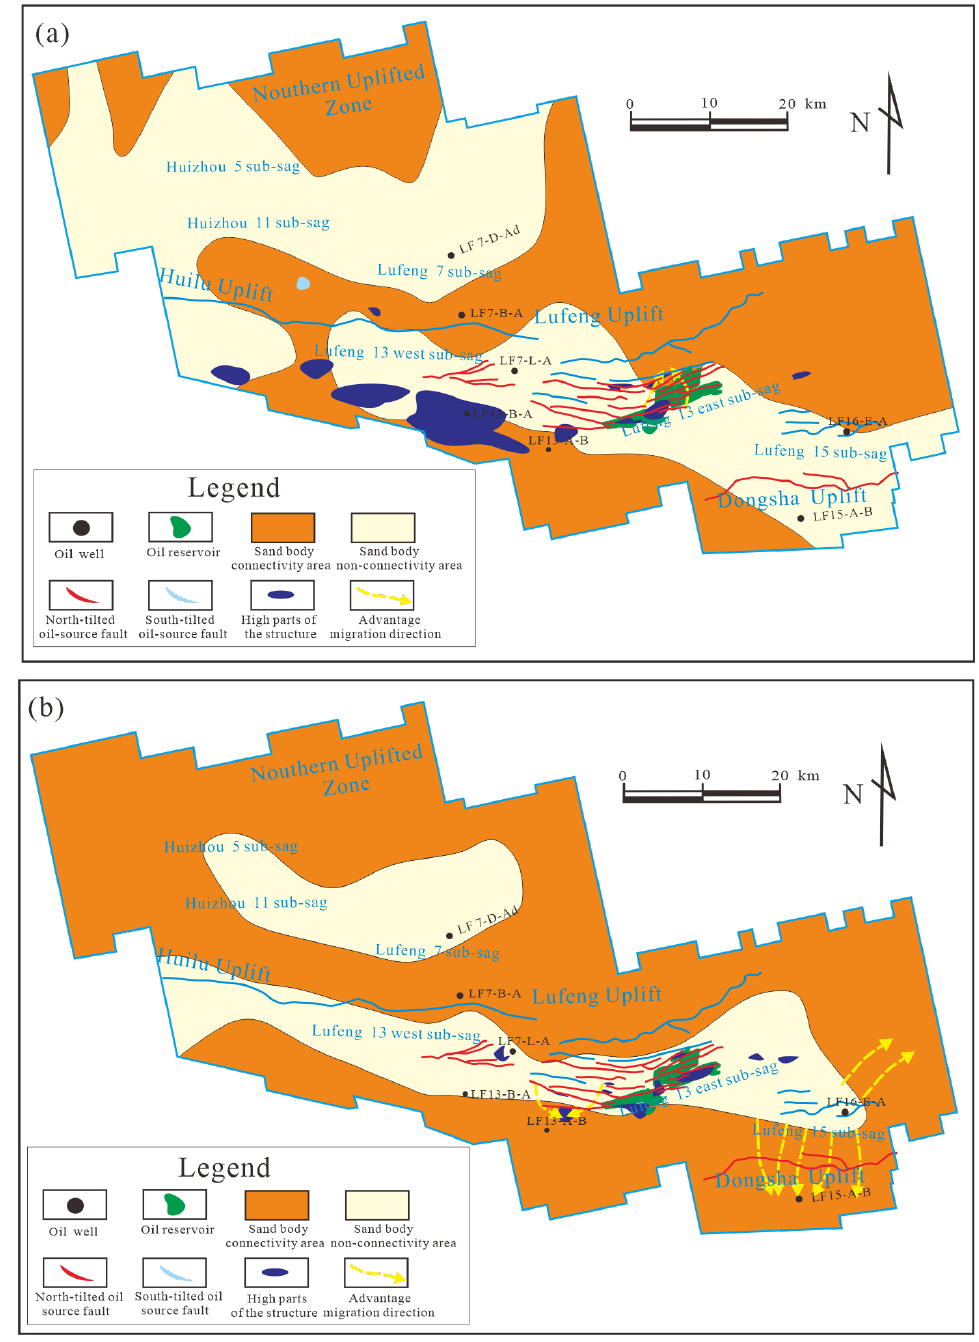
Figure 18. Plane distribution characteristics of composite oil and gas migration system (including oil – source faults, connected sand bodies, and structural ridges): ( a ) the upper WC; ( b ) the lower WC.